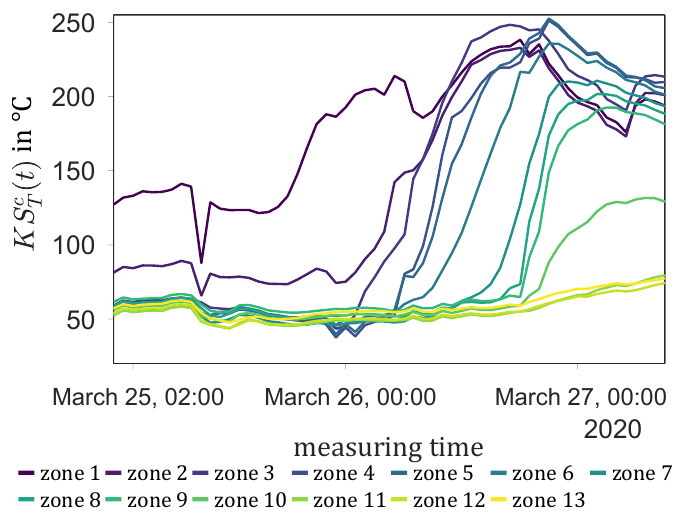
Figure 12. Profile of the temperature zones of a melting process in March